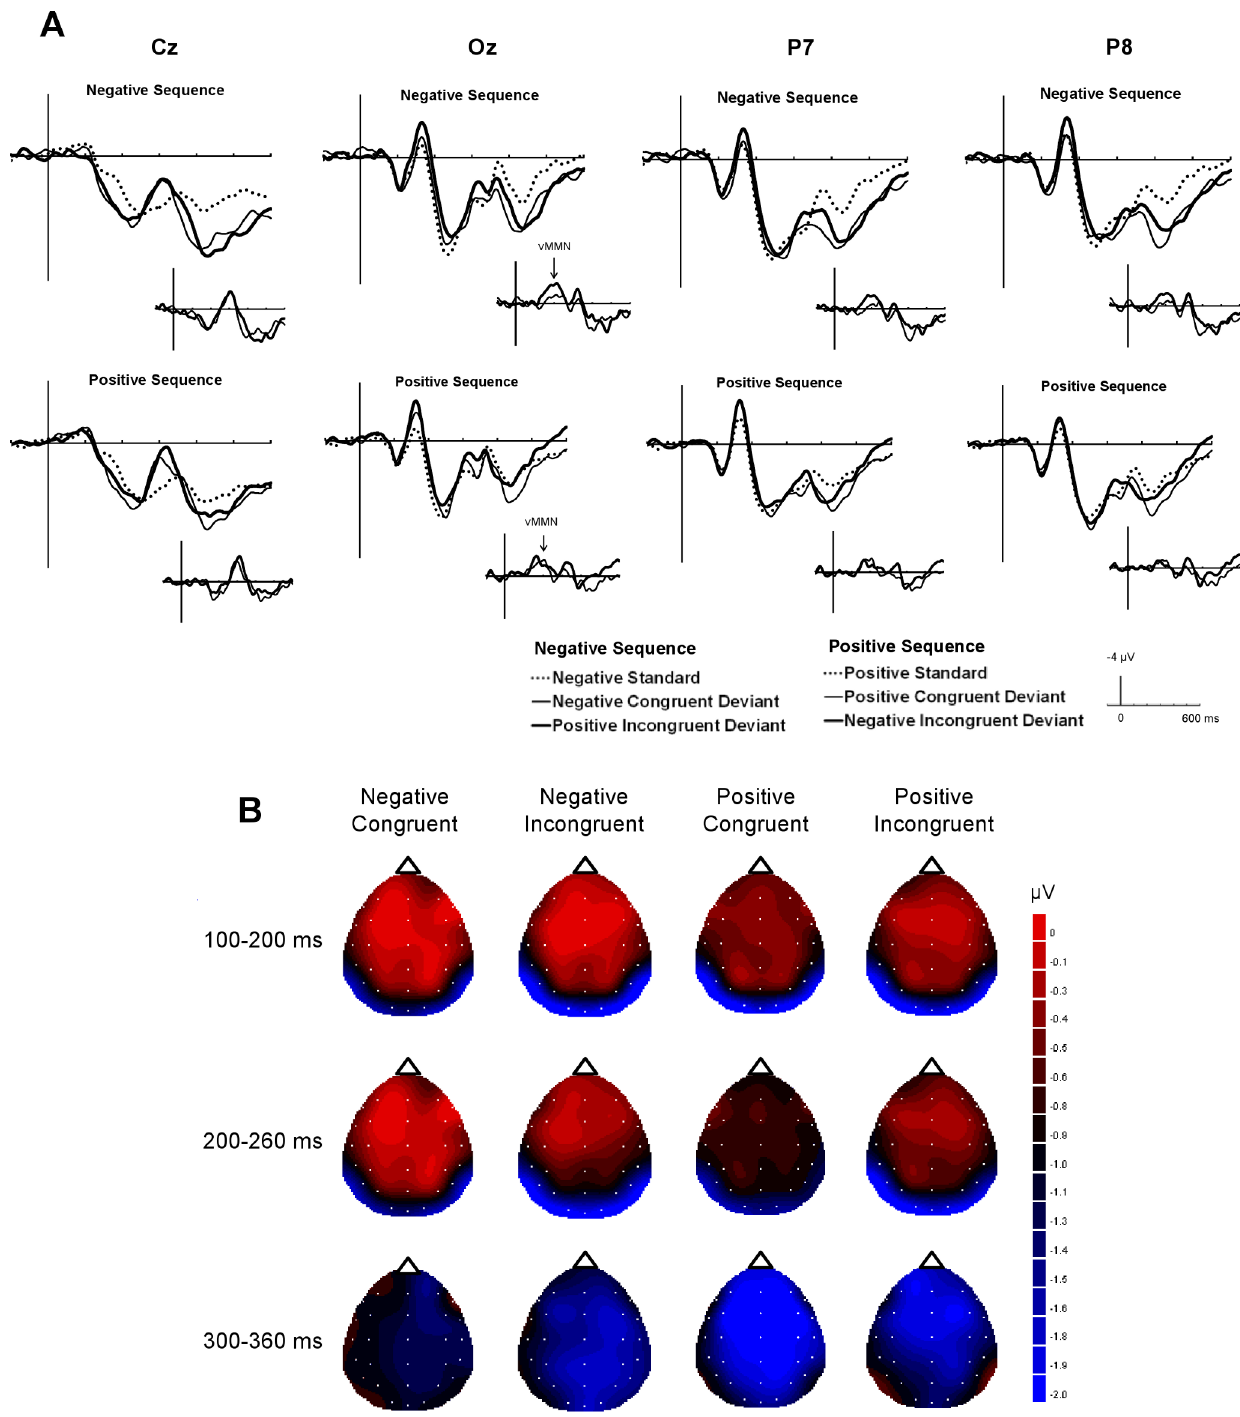
Figure 4. ERP results in Experiment 2. (A) The grand-average ERPs at Cz, Oz, P7, and P8 elicited by standards (dashed line), emotionally incongruent deviants (bold line), and emotionally congruent deviants (thin line) in negative and negative sequences. The inset shows vMMN, grand average deviant-minus-standard, for emotionally incongruent deviants (bold line) and emotionally congruent deviants (thin line). (B) The topographies of the voltage difference between the standards and the deviants at the peak latencies for each time period. The calculations for the differential ERP waves between standards and deviants were performed within each sequence (i.e., the ERP amplitude for positive standards was subtracted from that for incongruent negative deviants and congruent positive deviants). The images have been flattened into a two-dimensional space using the global interpolation method, which uses all electrodes to calculate values at any given point, viewed from the top of the head.